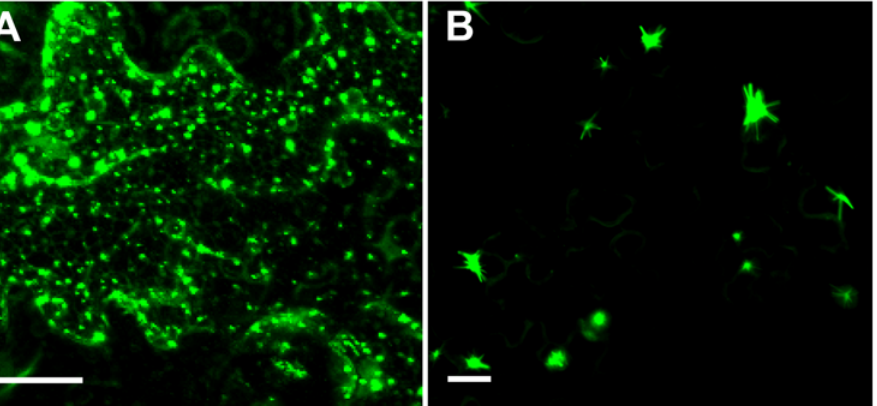
Figure 9. Location patterns of VER2-S33G and VER2-T209A mutations fused to GFP. (A) VER2-S33G mutation. (B) VER2-T209A mutation. Bars, 20 m